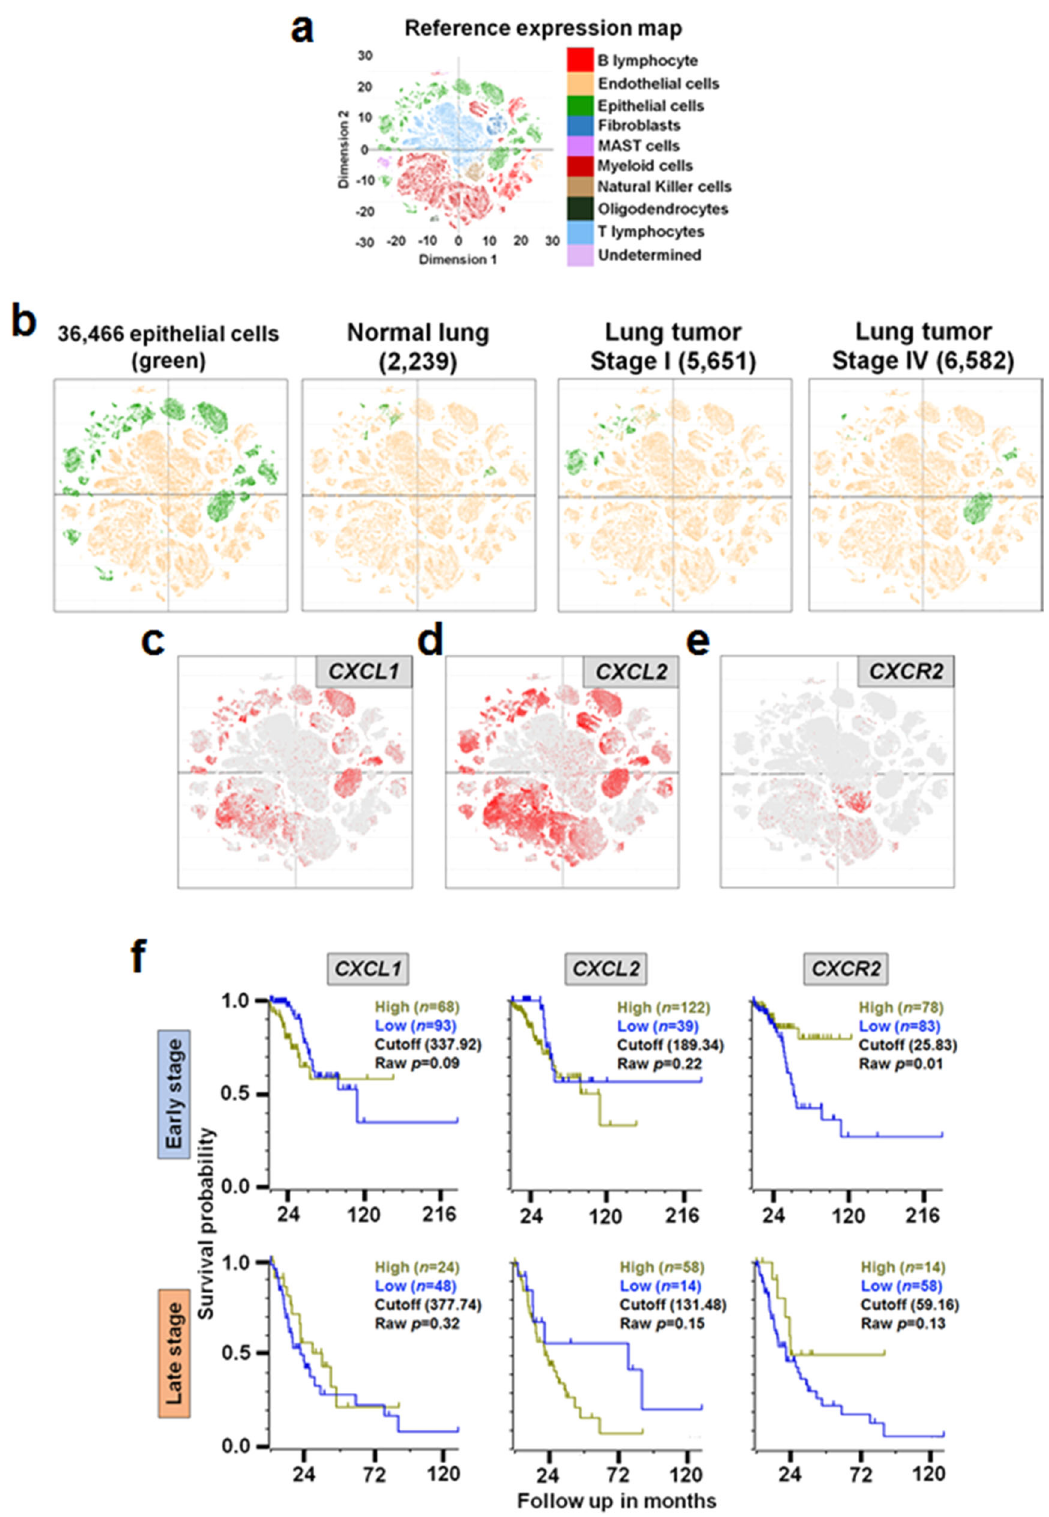
From GSEA, we showed that diverse biological processes can be affected by differential expression of individual genes or gene families at single-cell resolution in NSCLC cells (Table 1 and Fig. 3). The GSEA with the up-regulated gene set in Cluster 4